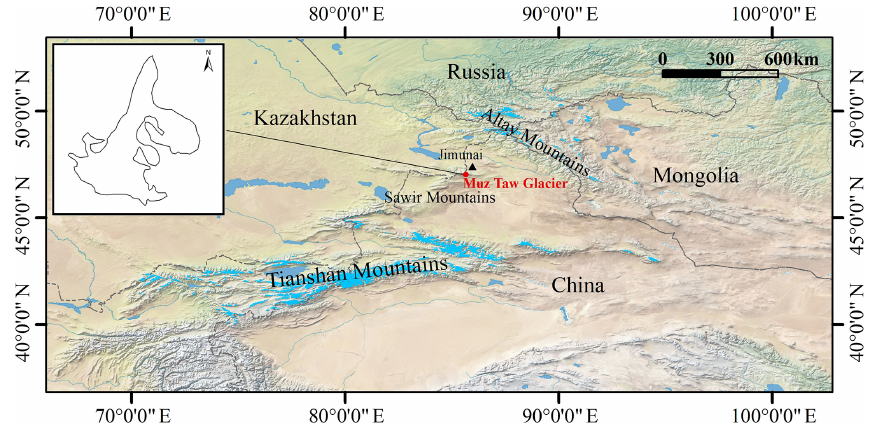
Figure 1. Location of the Muz Taw Glacier and the Sawir Mountains; the map in the background was made with © Natural Earth and is available at https://www.naturalearthdata.com/ (last access: 2 August 2020), and the outline of the glacier was sourced from Guo et al.